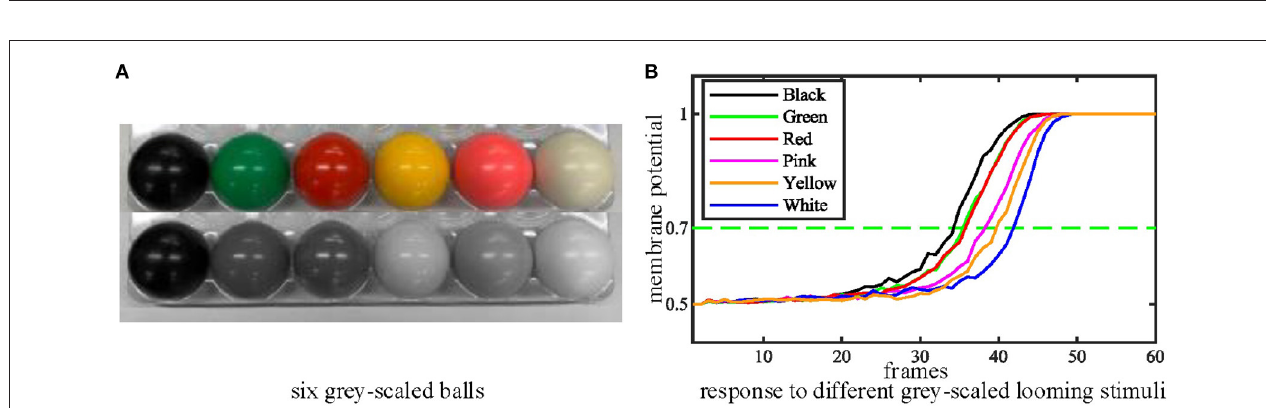
In the rotational tests, we examined the selectivity of the FFI mechanism by using a video captured while the camera is rotating. In this experiment, the panoramic camera rotates clockwise at a constant angular speed of around 90 deg